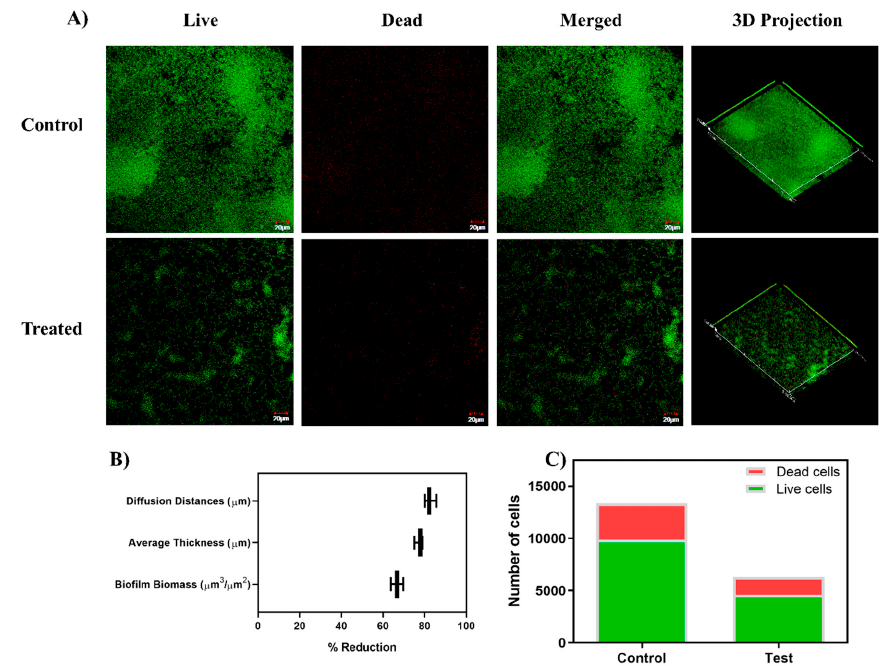
Figure 6. ( A ) CLSM (Confocal Laser Scanning Microscopy) micrographs illustrating the effect on the sub-inhibitory concentration of baicalein (200 µ M) on biofilm architecture and viability of the biofilm cells through Live/Dead staining. Baicalein treated cell cultures show sparing green color cells with no confluent mass, indicating inhibition of biofilm formation. ( B ) COMSTAT analysis of the CLSM images revealed a reduction in the biofilm biomass, average thickness, and diffusion distances in the baicalein treated biofilms compared to the untreated control. ( C ) ImageJ analysis shows the proportion of viable cells in the biofilm formed with baicalein treatment at the concentration of 200 μ M (MBIC 50 ).